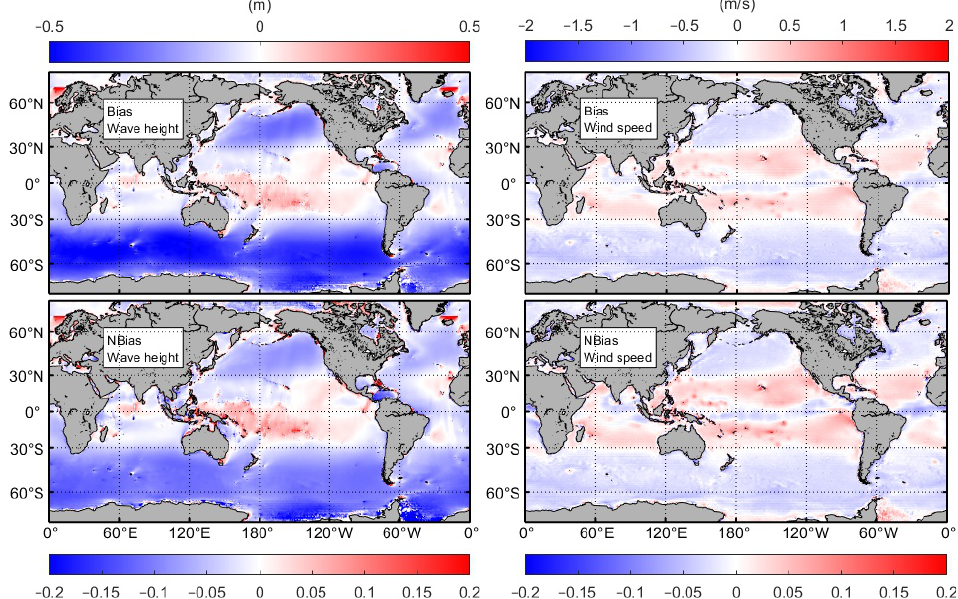
Figure 10. Mean annual variability of Bias, NBIAS (from top to bottom ) between the two reanalyses ( left : significant wave height, right : wind